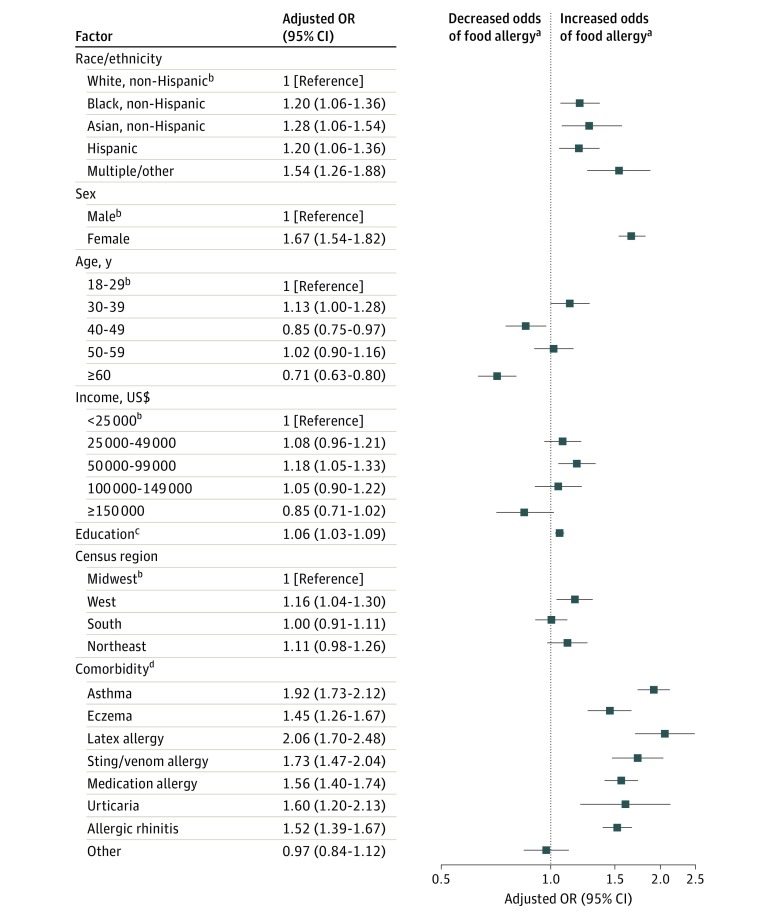
Factors Associated With Current Food AllergyEach square represents the odds ratio (OR) point estimate for each corresponding variable or sample characteristic, adjusting for all other variables in the logistic regression model. Each horizontal line represents the 95% CI. Percentages of all adults in each subgroup and adults with current food allergies in each subgroup are given in eTable 1 in the Supplement.aCompared with the reference group.bReference group.cEducational attainment was modeled as a continuous variable with the following 7 categories: less than high school, high school, some college, associates, bachelors, masters, and professional or doctorate.dThe reference group for each comorbid condition is the absence of that condition.